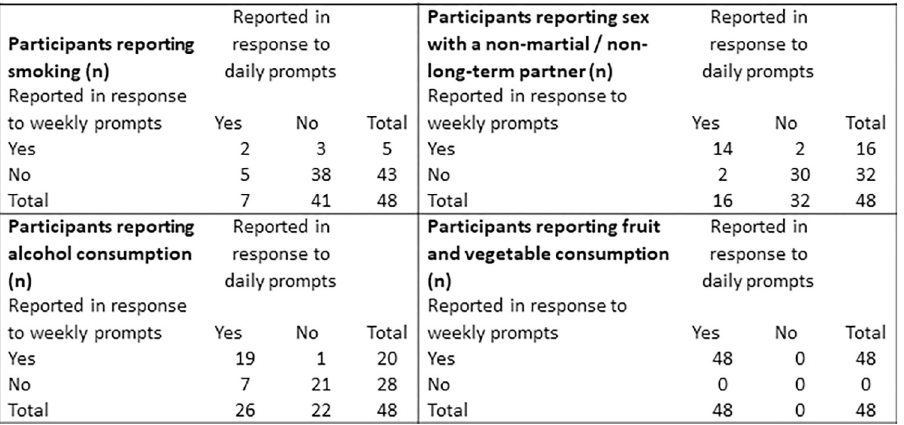
Fig 3. Comparison of ever reporting behavior in response to twice-daily versus weekly